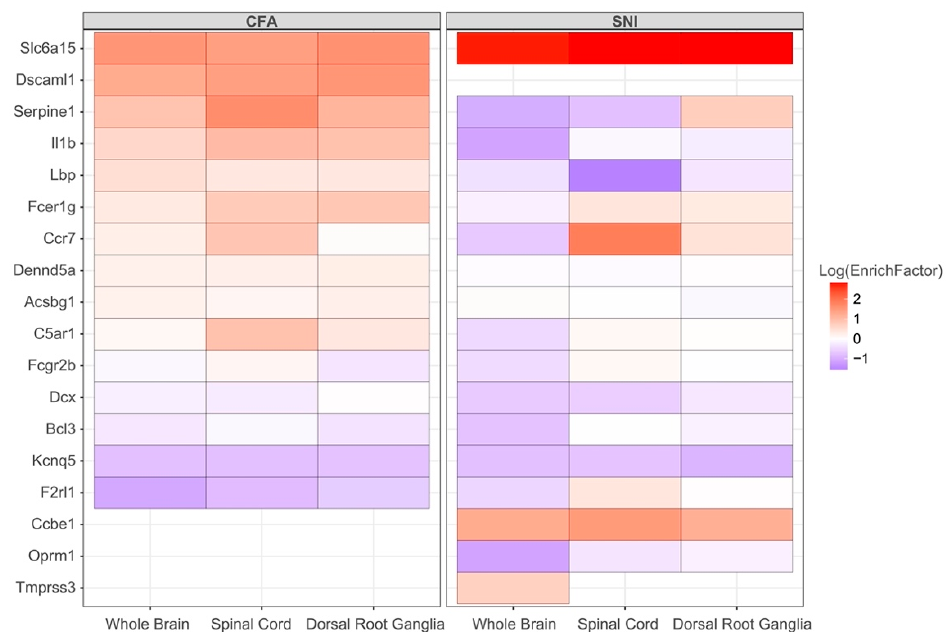
Figure 4. Differential gene expression in mouse models. Top: pain models, Bottom: tissue, CFA: complete Freund’s adjuvant, SNI: spared nerve injury. EnrichFactor: enrichment factor, shown as log-scaled values.